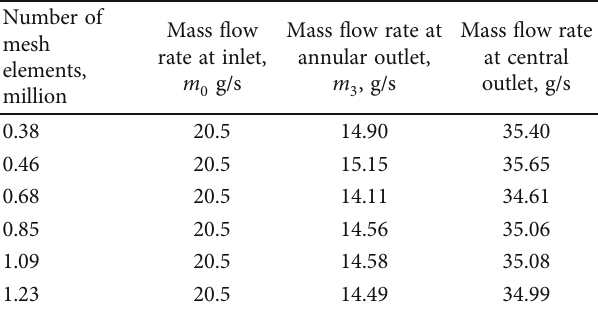
Table 2: Mesh independence